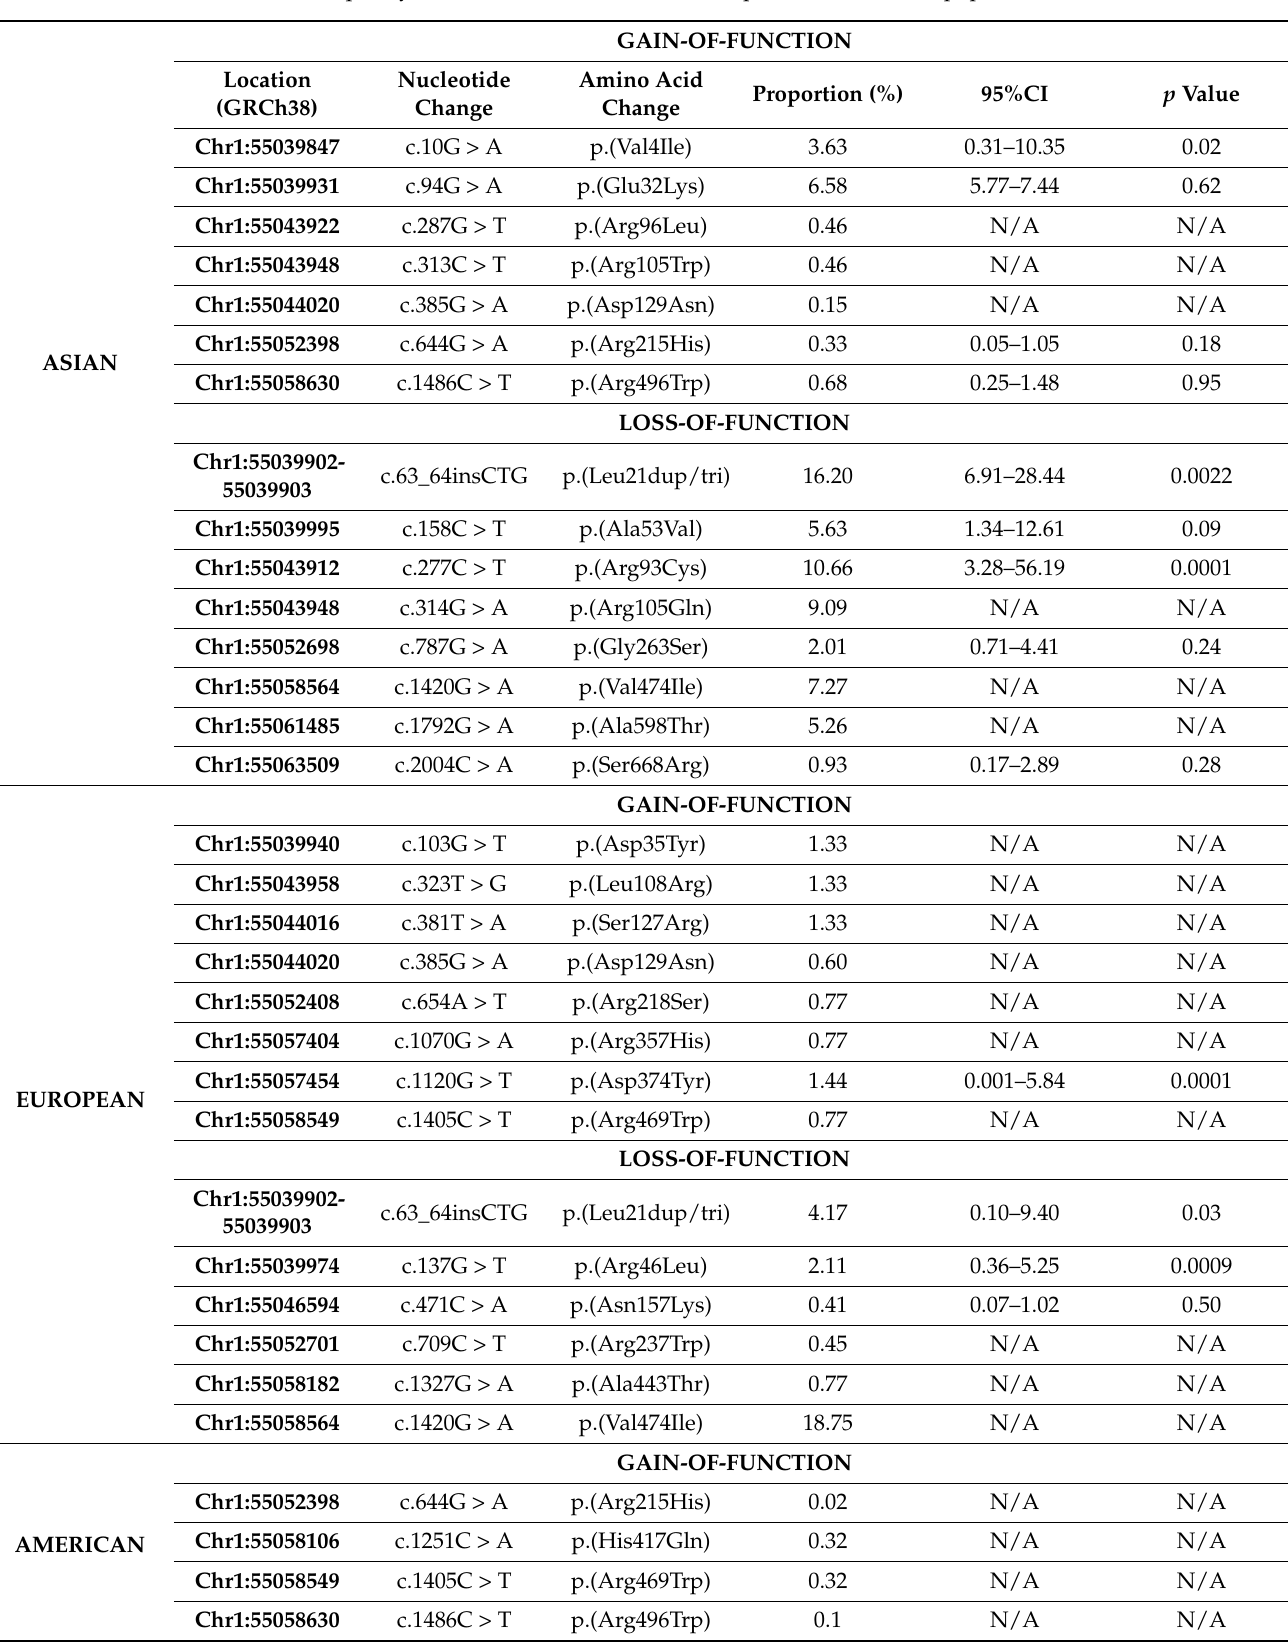
Table 4. Frequency of PCSK9 variants in Asian, European and American